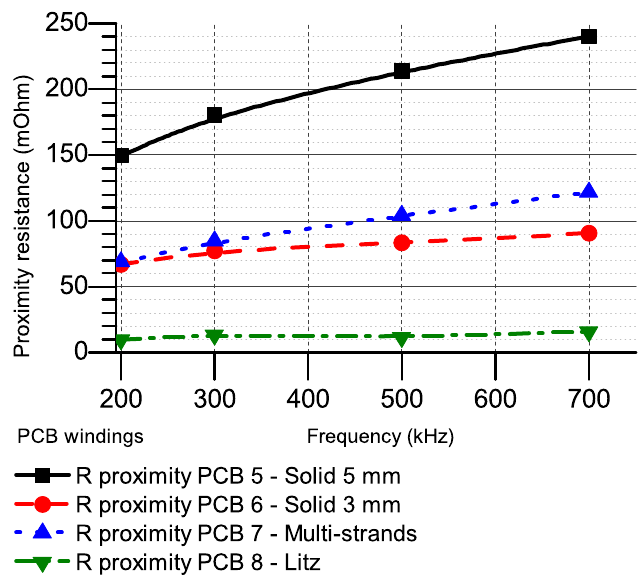
Figure 19. Calculated proximity resistances of 7-turn windings.